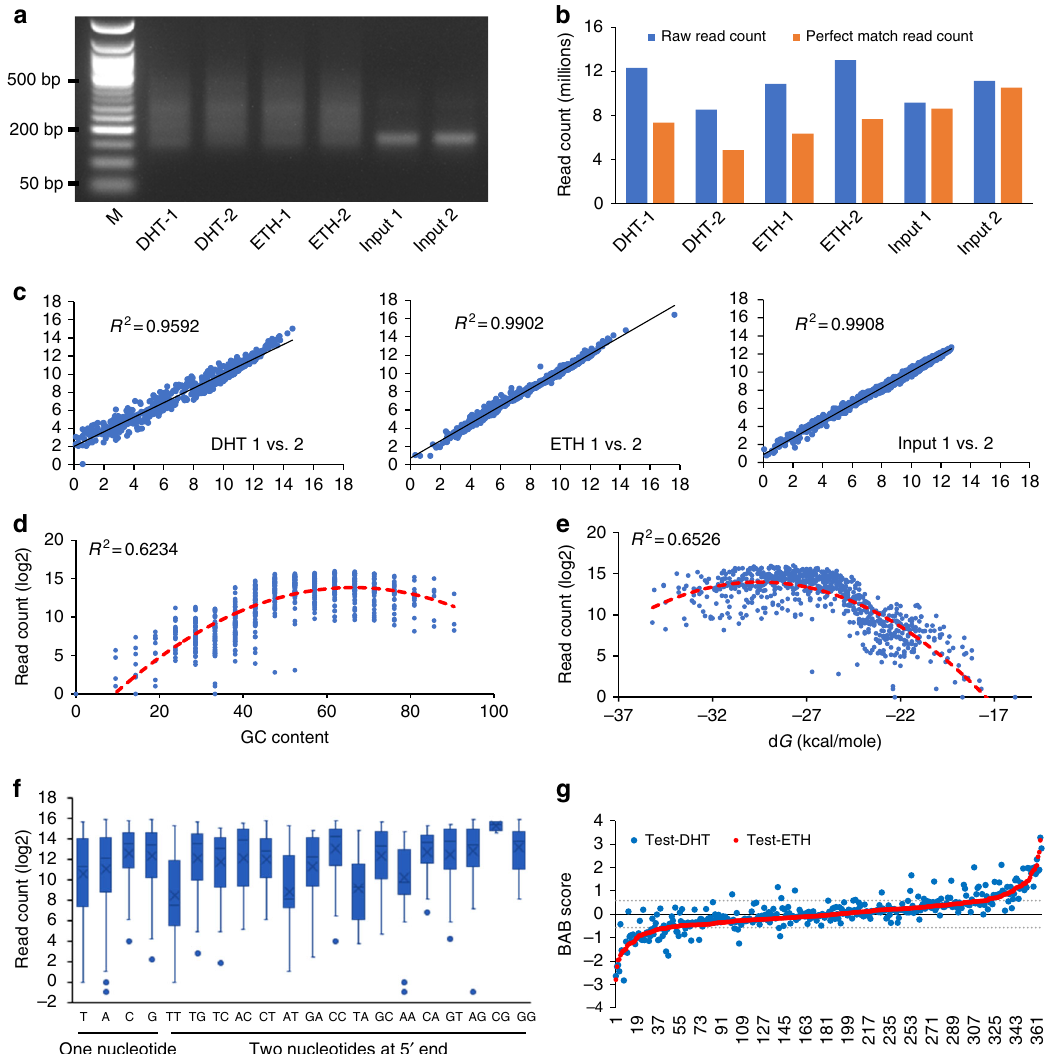
Fig. 3 SNPs-seq data analysis and BAB score distribution. a Size distribution of SNPs-seq libraries. Test samples show 150 – 500 bp length while input samples show ~160 bp. b Mapping of allele-speci fi c read counts. Percentage of mapped read count is ~60% for test samples and ~95% for input controls. c Correlation between technical replicates. Mapped read counts were fi rst transformed to log2 values, and then plotted along x (replicate 1) and y (replicate 2) axis. d Association of read count with GC content. Low GC content is signi fi cantly associated with low read count. e Association of read counts with delta G value. More thermostability of oligo duplex (lower delta G ) contributes to higher read counts in SNPs-seq library. f Association of read counts with nucleotides at 5 ′ end. The nucleotides A, T, AA, AT, TA, or TT at 5 ′ end have the lowest read counts among all tested oligos. The upper, middle, and lower bounds of boxes represent the 75th, 50th, and 25th percentile of the values, respectively. The whiskers represent 95th to 5th percentile. g Overall distribution of BAB scores among the 374 tested candidate SNPs. The red line represents BAB scores in ETH group while the blue dots represent the corresponding BAB scores from the DHT